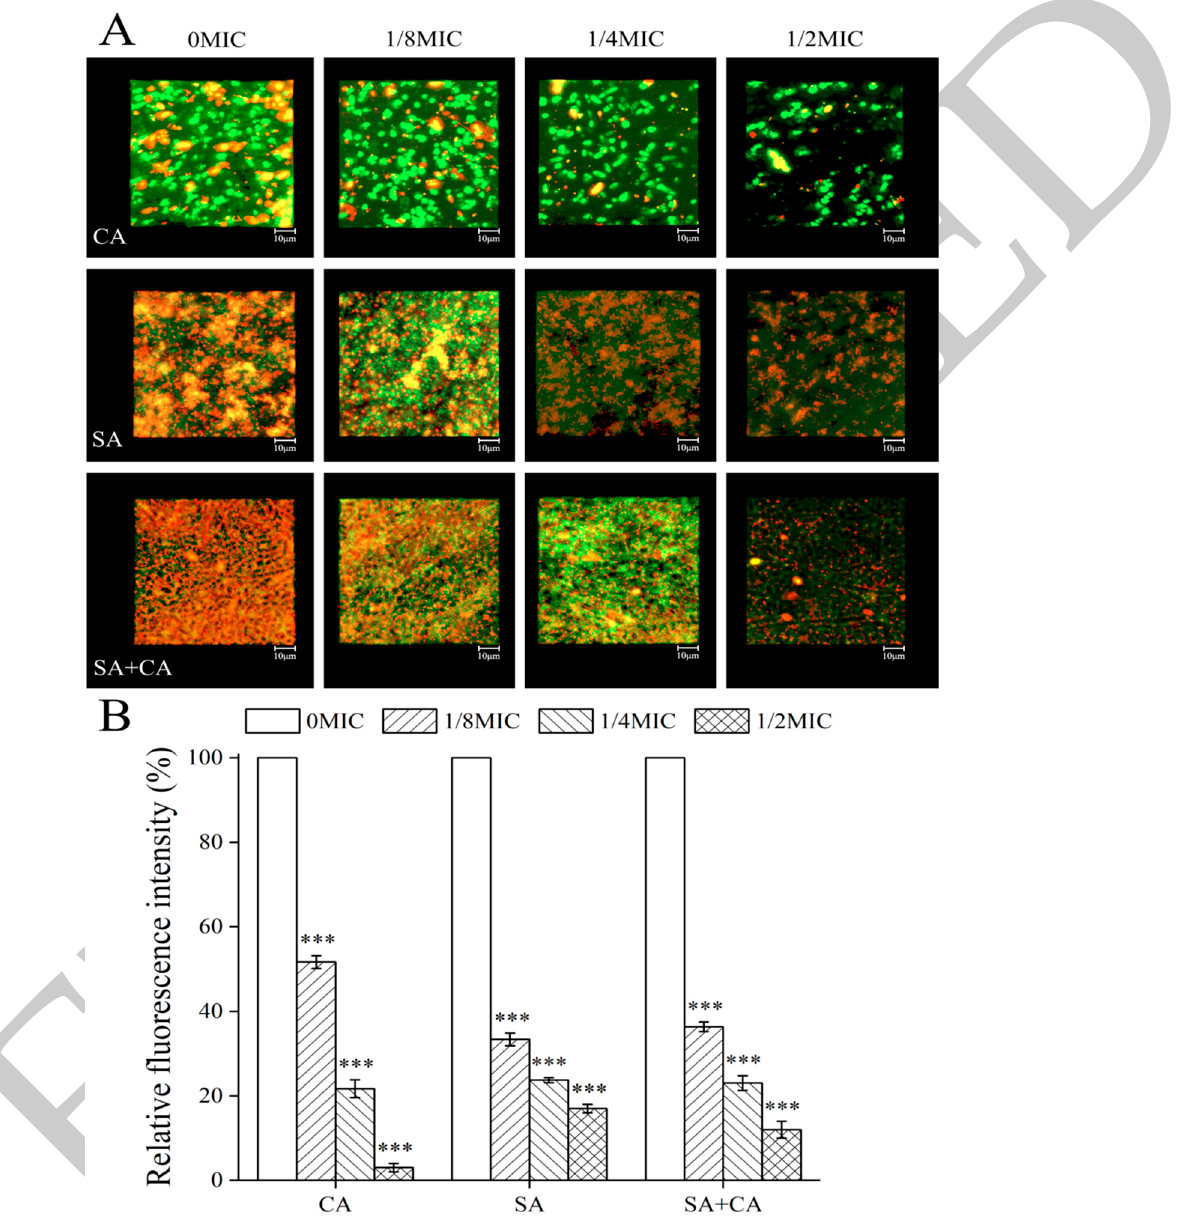
Figure 5. Effect of subMIC sanguinarine on the eDNA levels within C. albicans SC5314 (CA) and S. aureus CMCC26003 (SA) mono- and dual-species (SA + CA) biofilms by confocal laser scanning microscopy. ( A ) eDNA and microbial cells were labelled with a red fluorescent dye PI, and a green-fluorescent nucleic acid counterstain STYO 9, respectively. Scale bars represent 10 μ m. ( B ) The relative fluorescence intensity of eDNA in biofilms of each treatment group was calculated and plotted against that in untreated group by measuring red/green fluorescence ratios using KS 400 version 3.0 software. Bars represent the standard deviation (N = 6). *** p < 0.001.